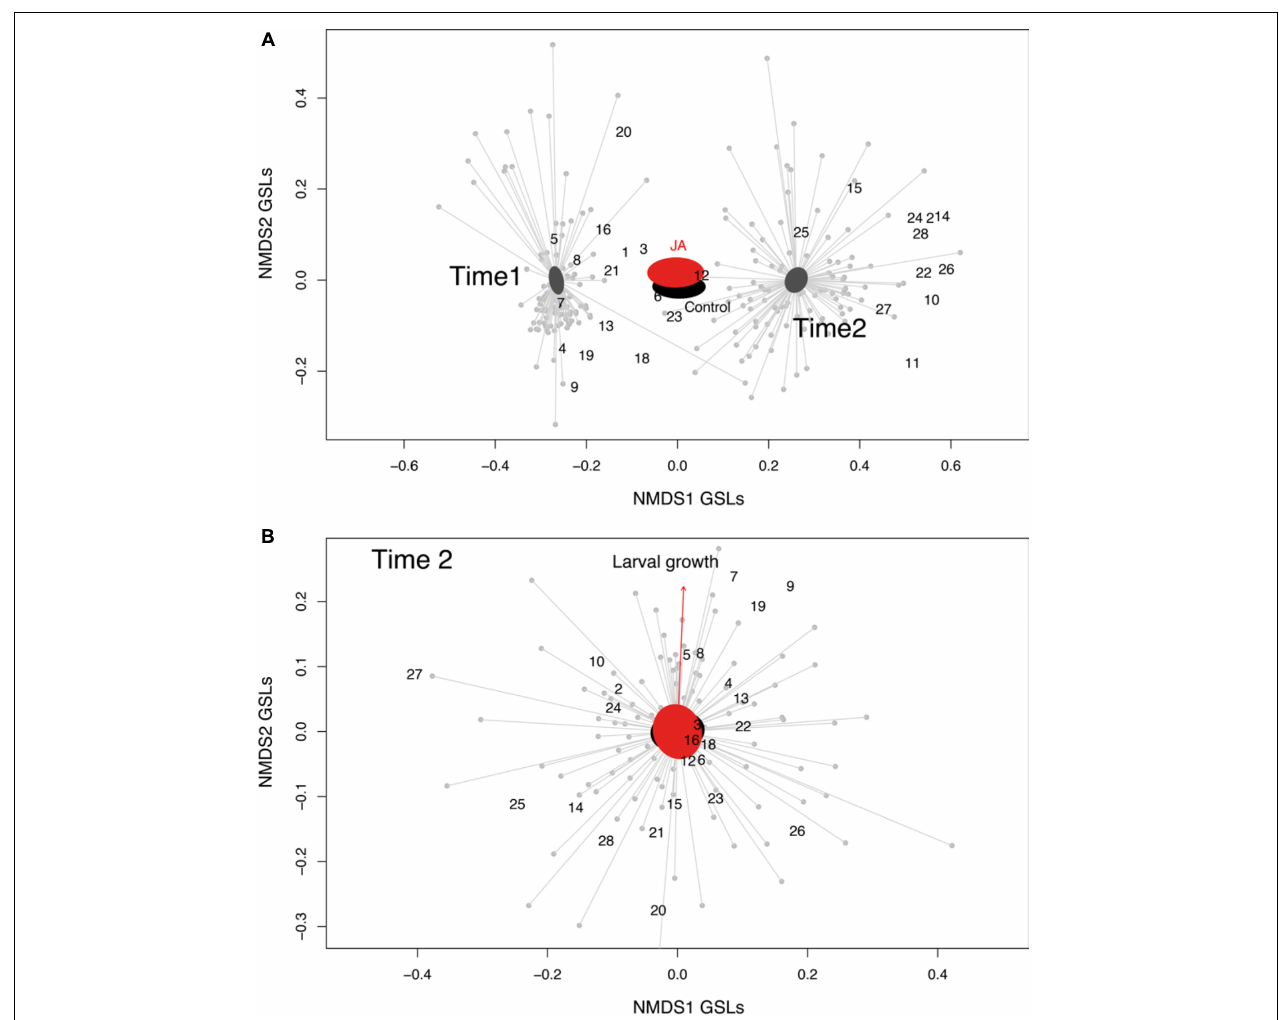
FIGURE 3 | Glucosinolates’ ordination. (A) Representation of the non-multidimensional scaling (NMDS) indicating the glucosinolates found in Cardamine hirsuta leaves, and their 95% confidence interval ellipses based on the two treatments (root induction with JA, red polygon; and no-induction as the black polygon) at two-time points; Time 1 = 4 days after induction and Time 2 = 11 days after induction (stress value = 0.14, k = 2). (B) Effect of glucosinolates on larval growth. Representation of the non-multidimensional scaling (NMDS) indicating the glucosinolates found in C. hirsuta leaves, and their 95% confidence interval ellipses based on the two treatments (root induction with JA, pink polygon; and no-induction as the green polygon). The projection of the maximal correlation of the larval weight gain vector (from the envfit model) on the NMDS ordination is also shown (red arrow) (stress value = 0.26, k = 2). Glucosinolates are: 1 = Glucoraphanin, 2 = Hydroxypropyl-GSL, 3 = Progoitrin, 4 = Glucoalyssin, 5 = Glucoputranjivin, 6 = Sinalbin, 7 = Gluconapin, 8 = Butyl-GSL, 9 = Glucobrassicanapin, 10 = Veratryl-GSL, 11 = Glucohirsutin, 12 = Glucoerucin, 13 = Glucotropeolin, 14 = Trimethoxy-GSL, 15 = 5-Benzoyloxypentyl, 16 = Glucobrassicin, 17 = 2-Hydroxy-2-phenylethyl-GSL, 18 = Glucoberteroin, 19 = Gluconasturtiin, 20 = Methoxyglucobrassicin, 21 = Neoglucobrassicin, 22 = 8-Methylthiooctyl-GSL, 23 = Gluconapoleiferin, 24 = Hydroxymethylbutyl-GSL, 25 = 2-Methylbutyl-GSL, 26 = Unknown-GSL, 27 = Hydroxybenzyl-methylether GSL, and 28 = Unknown-GSL.